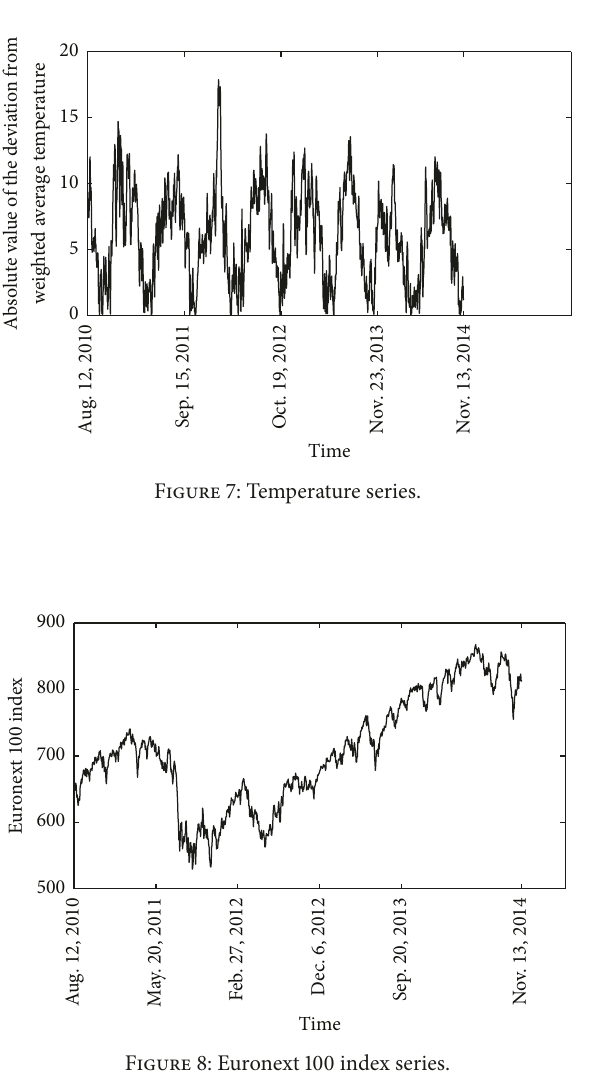
Figure 8: Euronext 100 index series.